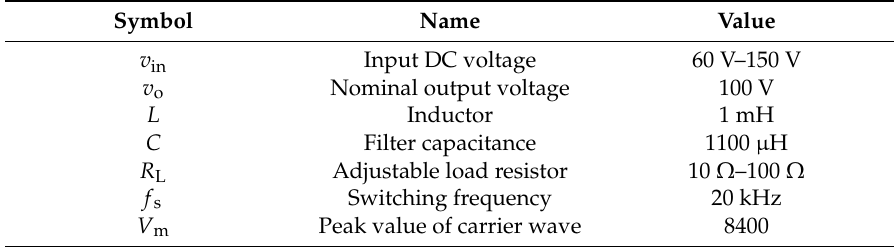
Table 1. Simulation and experimental parameters.